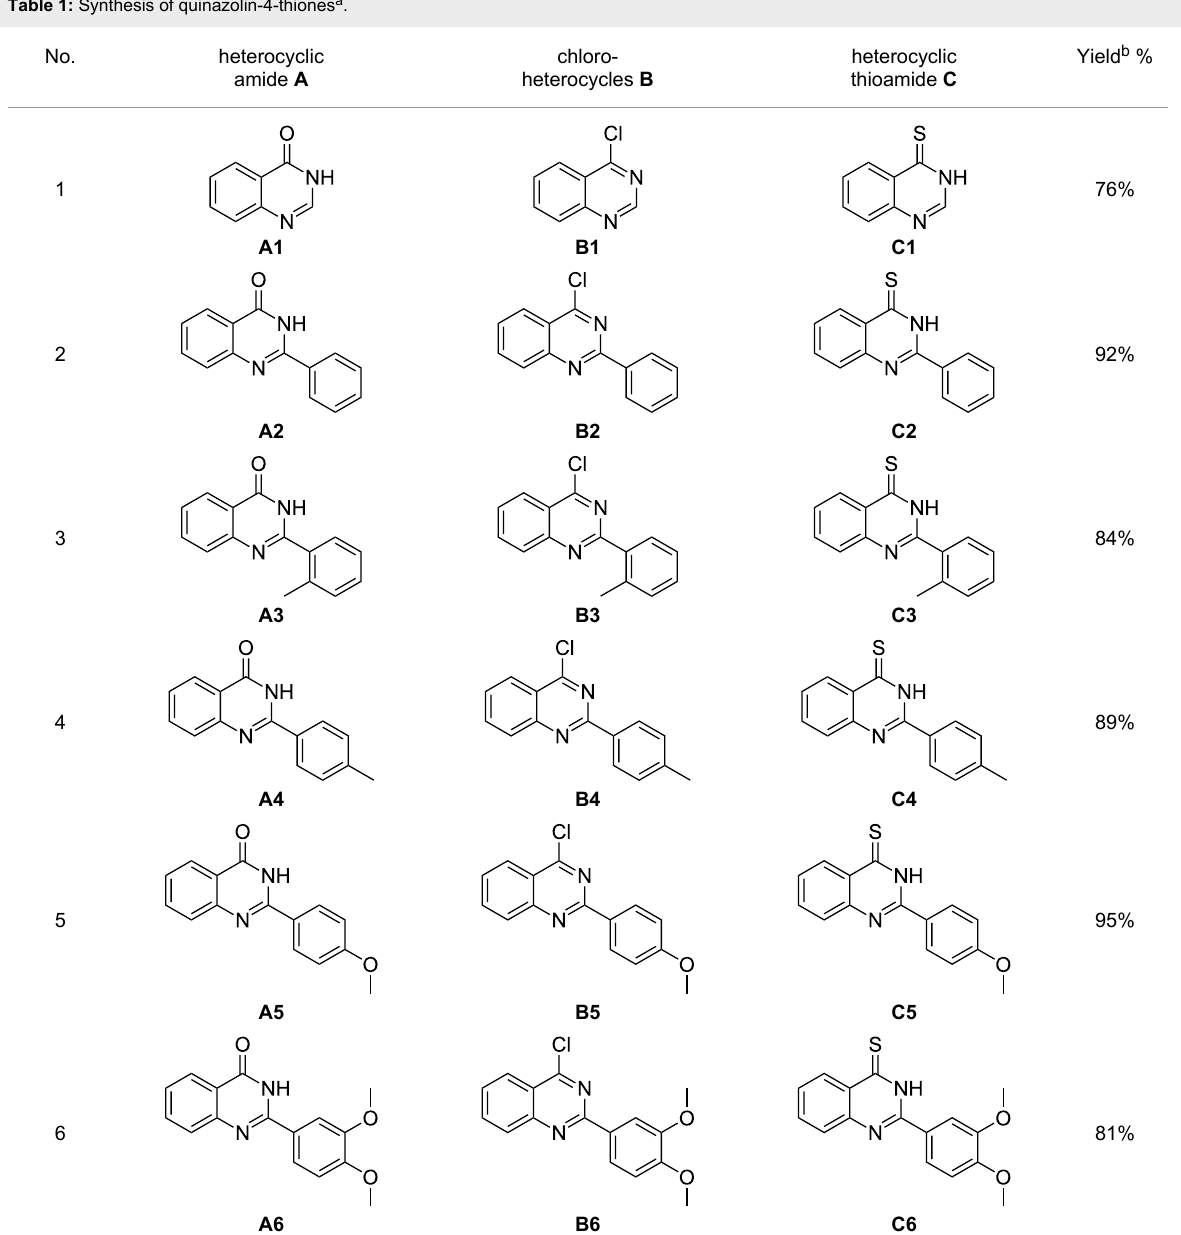
Table 1: Synthesis of quinazolin-4-thiones a